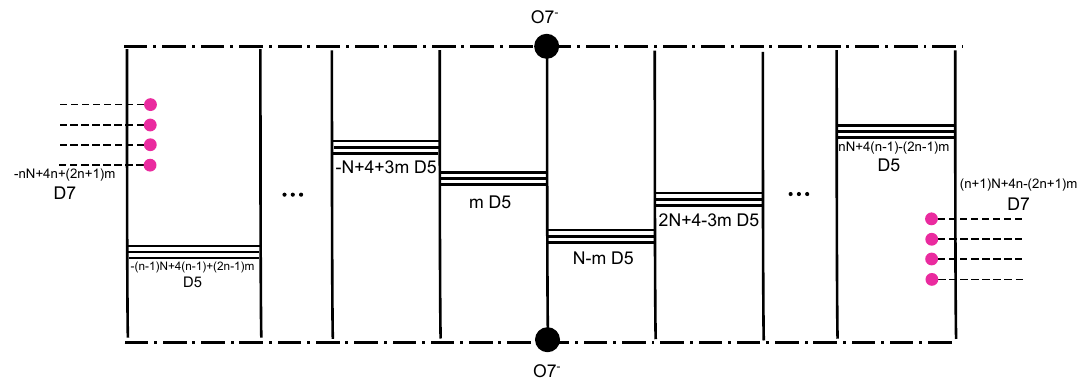
Figure 35 . Type IIB brane con(cid:12)guration after performing a T-duality to (cid:12)gure